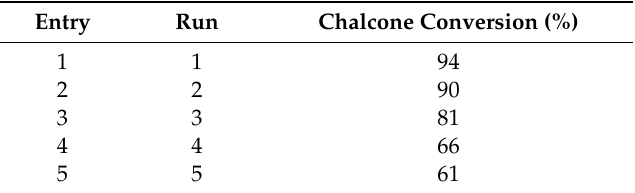
Table 5. Chalcone conversion during 5 runs.